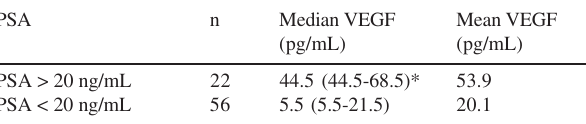
P < 0.001; * interquartile range